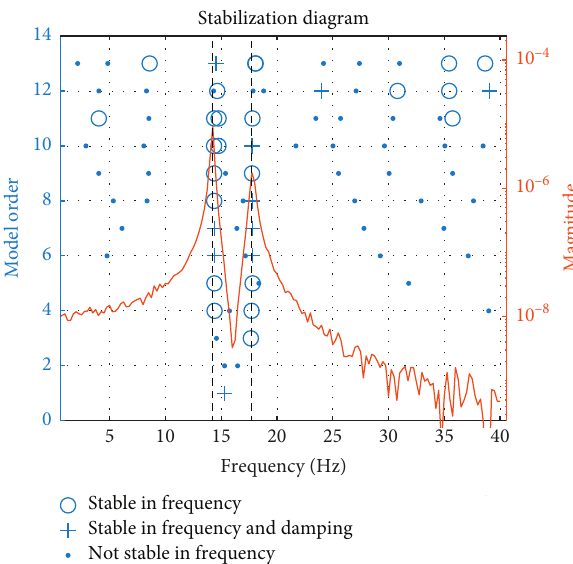
Figure 14: Stabilization diagram utilizing PolyMAX identification in frequency